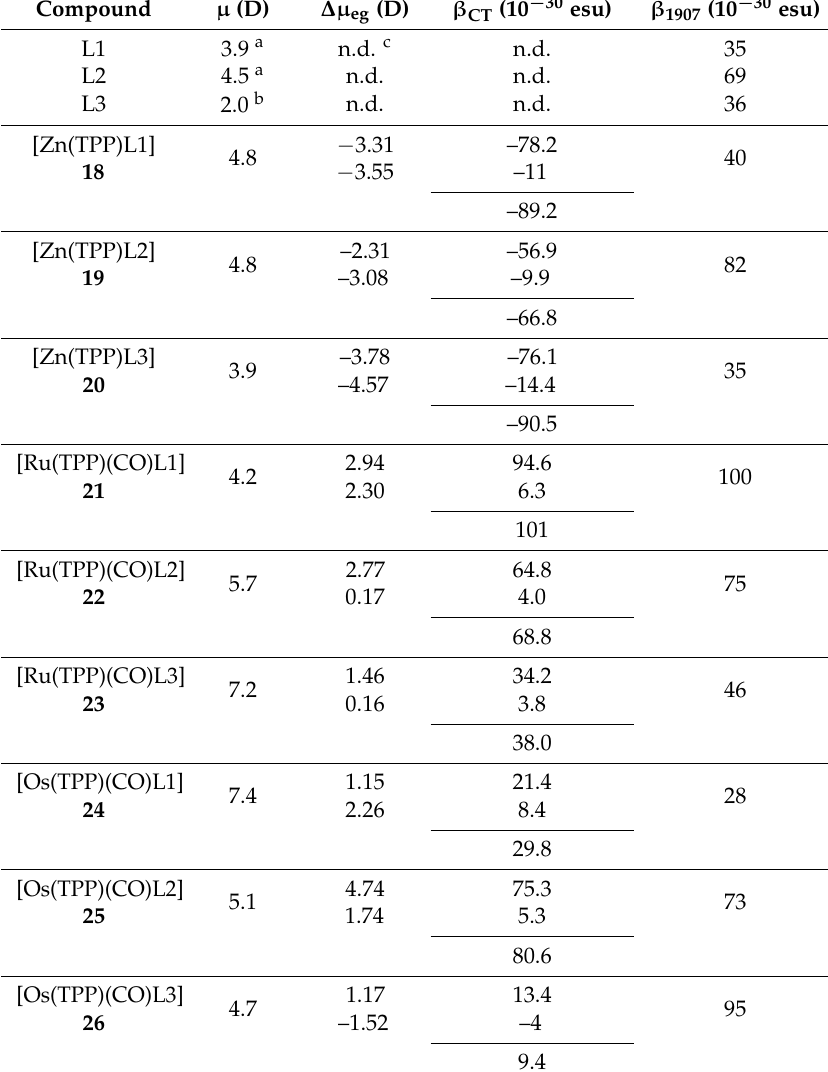
Table 2. Dipole moments ( µ ), solvatochromic data ( β CT ) and EFISH quadratic hyperpolarizability ( β 1907 ) in CHCl 3 working with an incident wavelength of 1907